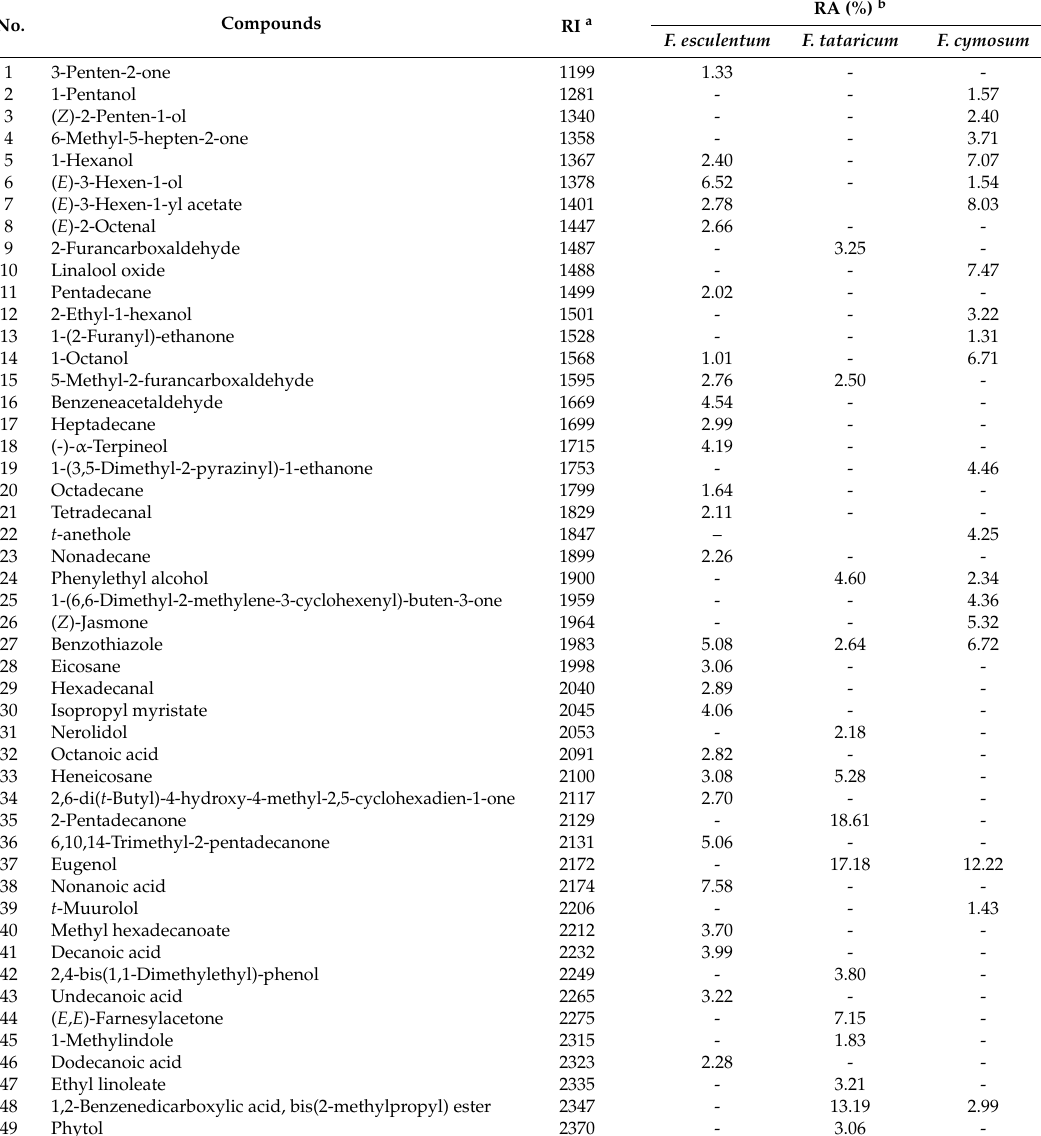
Table 2. Chemical composition of the volatile oils from the flowers of F. esculentum , F. tataricum and F. cymosum by GC-MS